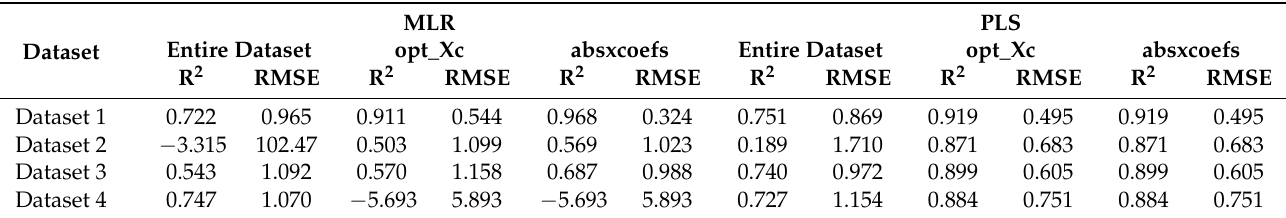
Table 4. Prediction scores for the TSS content of intact berries of Thompson seedless grapes, using 75% of the spectra for PLS regression model